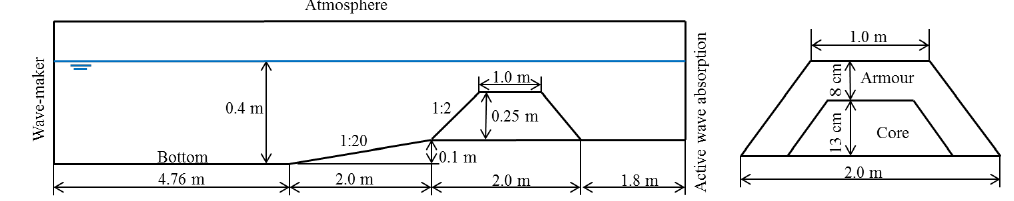
Figure 14. Sketch of the computational domain for the porous low-crested rubble-mound breakwater case.